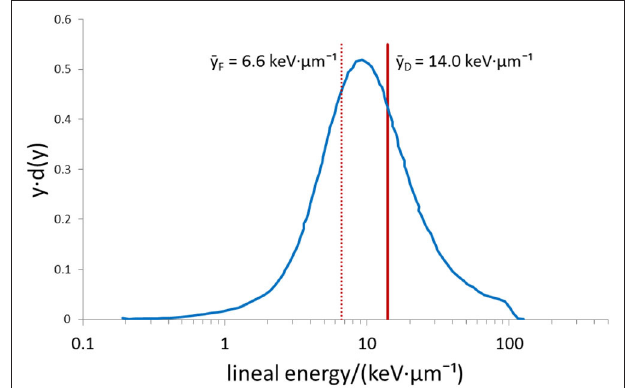
FIGURE 5 | Typical microdosimetric spectrum collected using a tissue-equivalent proportional counter (TEPC) in a proton beam. The two vertical lines represent the mean values y F and y D estimated from the